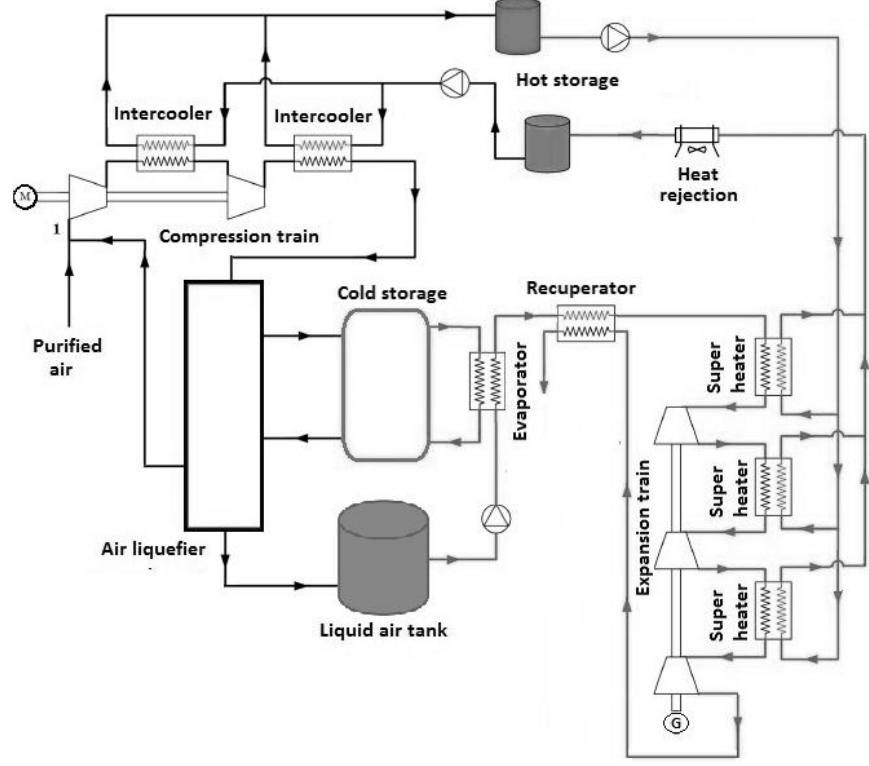
Figure 2. Typical configuration of a standalone LAES plant — scenario A.